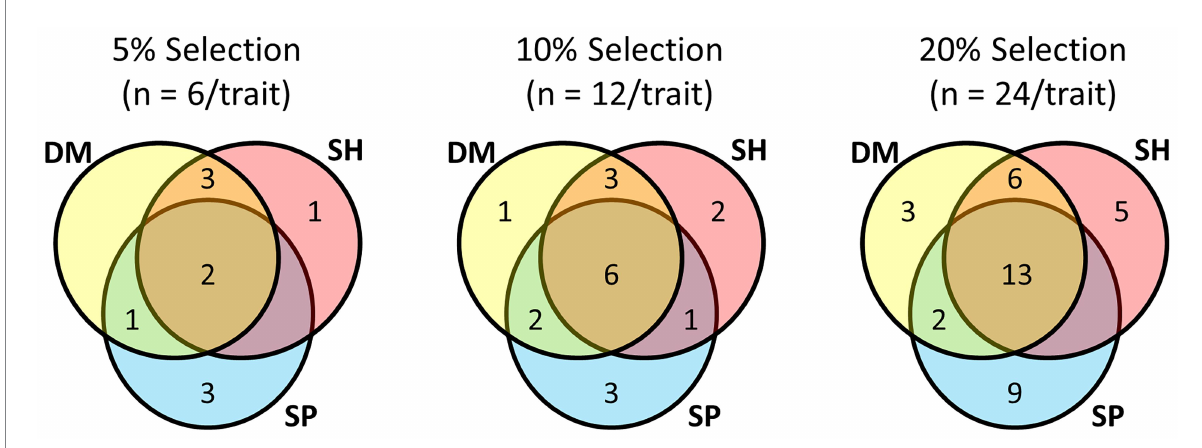
FIGURE 4 Commonality of half-sib families among selections made for symbiotic traits Shoot Dry Matter (DM), Shoot symbiotic potential (SP), and a Smith- Hazel (SH) multi-trait selection index for both Shoot DM and SP at three selection pressures. From a total of 120 half-sib families inoculated with the Rhizobium leguminosarum bv. trifolii strain TA1, 5% selection pressure selected the top ranked six families for each trait or SH index, based on trait BLUPs or SH index, 10% comprised the top ranked 12 families, and 20% the top ranked 24 families for each trait or SH index. BLUP and Smith- Hazel index values are presented in Supplementary Table